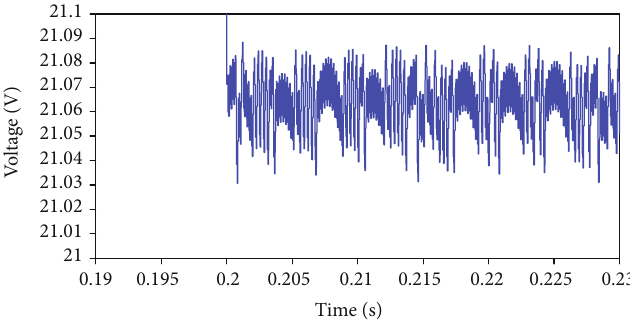
Figure 30: The output voltage of PV1 in detail, when the bypass diode of panel 3 has